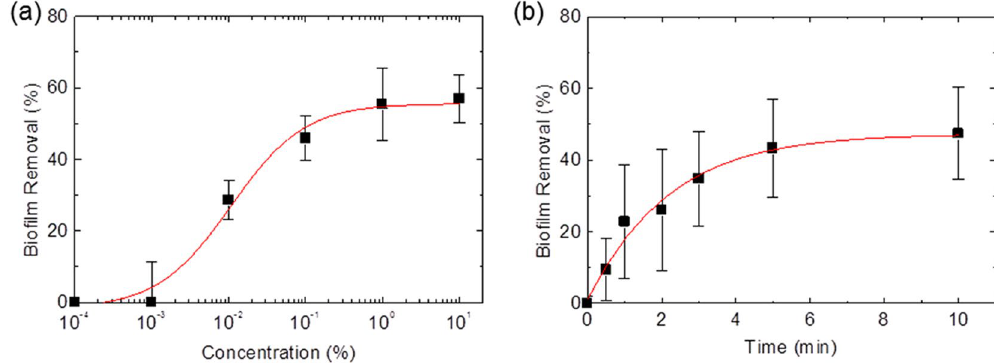
Figure 2. ( a ) Dose-dependent correlation between biofilm-removal efficiency and the amount of betaine- erythritol mixture. Concentration value represents the weight fraction of the mixture of betaine and erythritol. A mixture of betaine and erythritol at a 2:1 molar ratio was serially diluted with water. ( b ) Time-dependent correlation between biofilm-removal efficiency and exposure time of the solution containing betaine and erythritol at a molar ratio of 2:1. The solution used included 0.1% betaine-erythritol mixture, i.e., 5.6 mM betaine and 2.8 mM erythritol. Each point and error bar indicates mean and SD, respectively ( n =